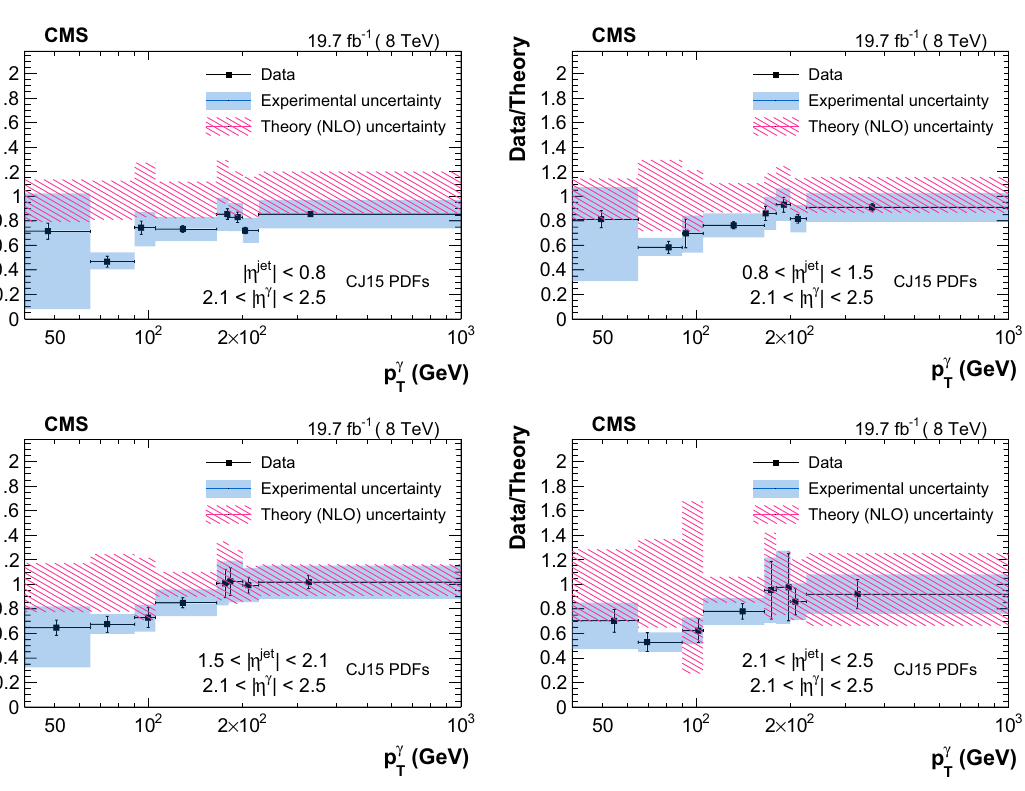
Fig. 8 Ratio of triple-differential cross sections as a function of p measured in data over the corresponding GamJet NLO theoretical pre- diction (obtained with the CJ15 PDFs) in different bins of | η jet | for